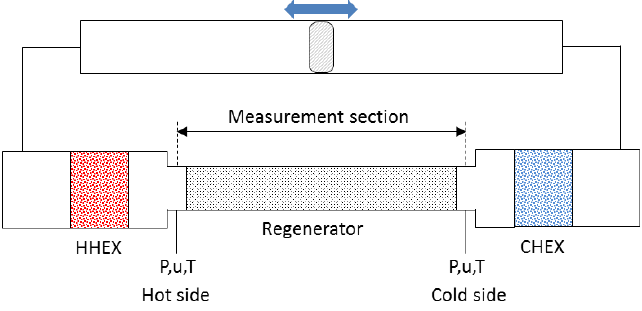
Figure 3. Schematic of the alternating flow regenerator test bench.